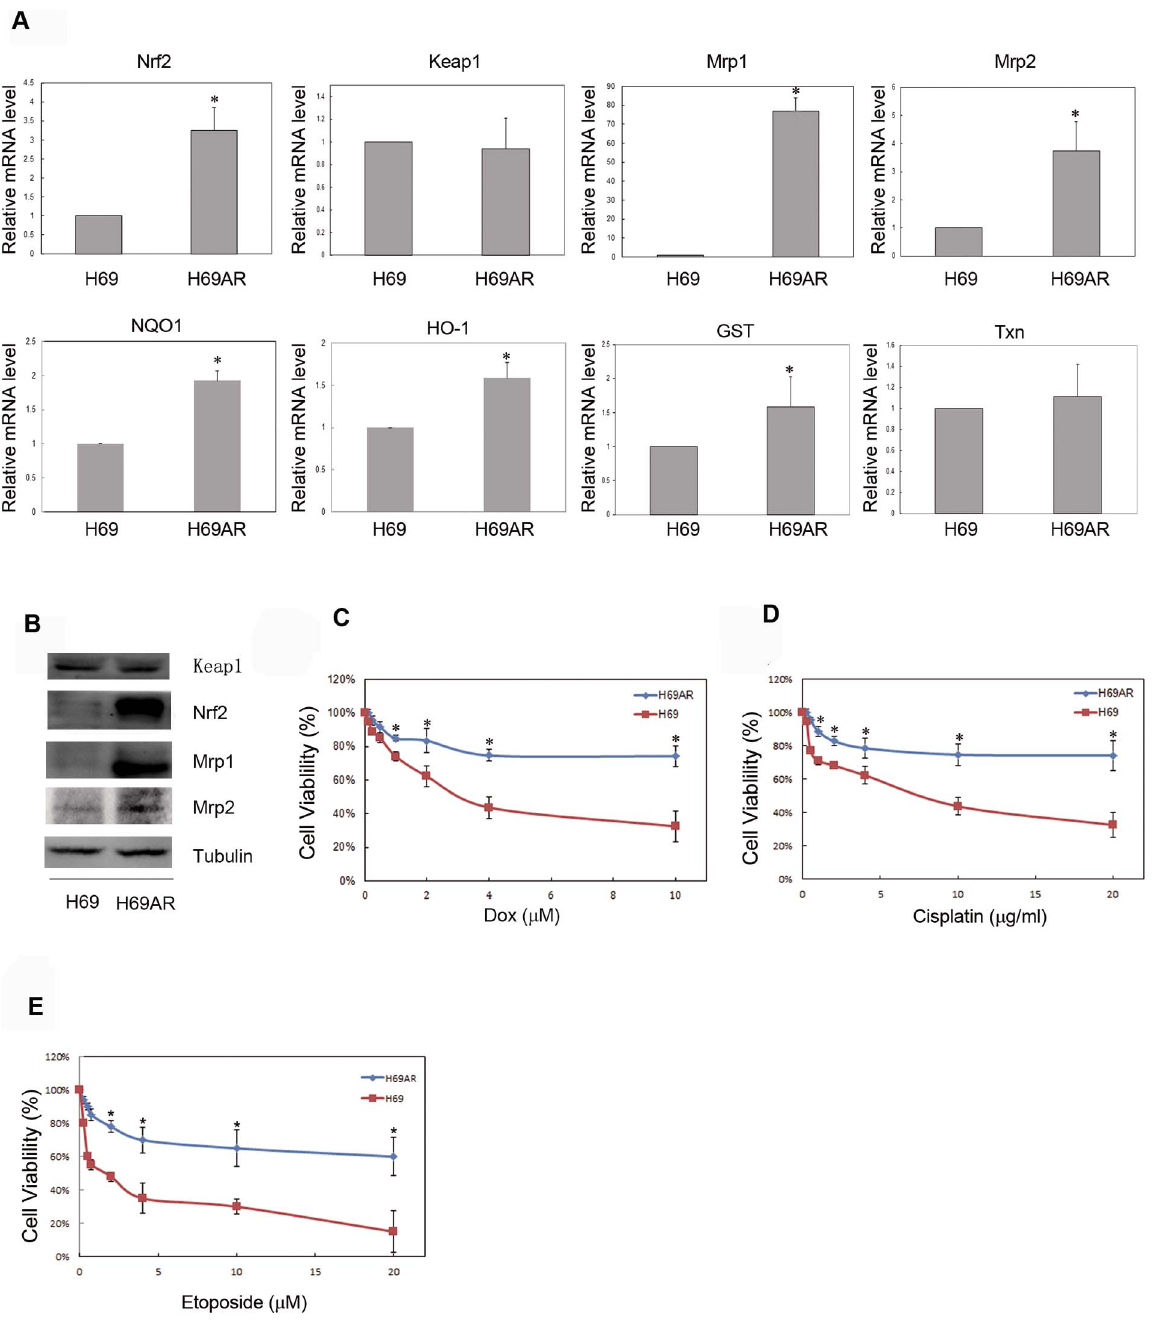
Figure 1. Nrf2 involves in the expression of Mrp1 and MDR in H69AR cells. (A) Relative mRNA level of Nrf2, Keap1, Mrp1, Mrp2, together with NQO1, HO-1, GST and Txn was compared in H69 and H69AR cells by real-time RT-PCR using the DD Ct method with GAPDH as an internal control. Results were expressed as mean 6 SD from three independent experiments. (B) Protein level of Keap1, Nrf2, Mrp1, Mrp2 was compared in H69 and H69AR cells by Western blotting using Tubulin as internal control. Experiments were performed three times and a representative immunoblot was shown here. (C), (D) and (E) The viability of H69 and H69AR cells with treatment of Dox, Cisplatin and Etoposide in different doses for 24 hours was determined by MTT assay. The experimental differences were determined by two-tailed Student’s t-test and p , 0.05 was taken as a significant difference in all cases.